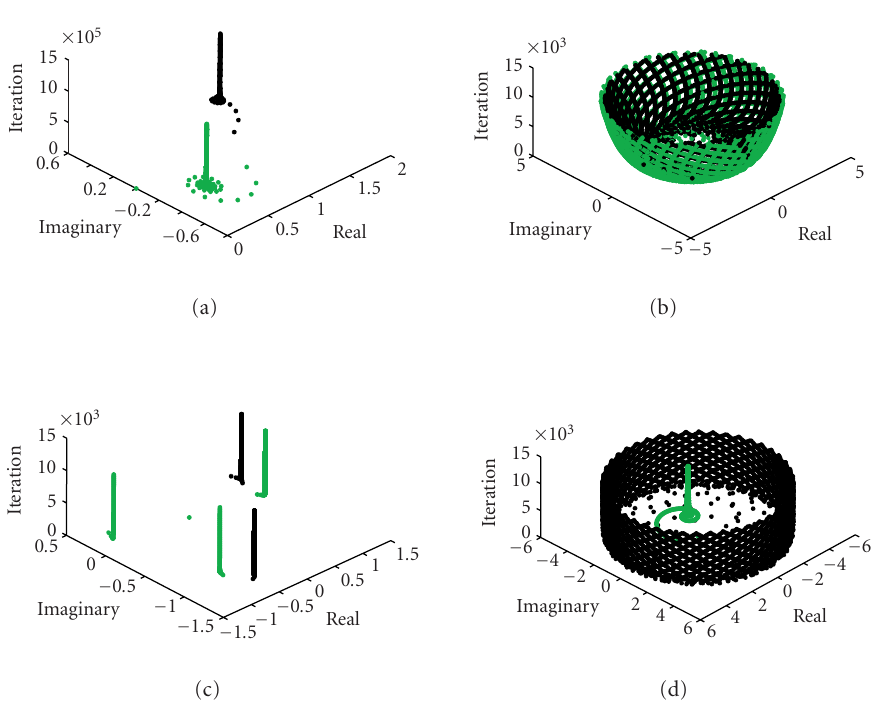
Figure 2.2. Dynamics for cycles of length c = 2,3, and 4. Shown are the iterates v n given by (2.1) with (a) ( a 1 , a 2 ) = (exp( iπ/ 4),exp( iπ/ 6)), (b) ( a 1 , a 2 , a 3 ) = (exp( iπ/ 4),exp( iπ/ 4),exp( i ( π/ 4 + 1 /